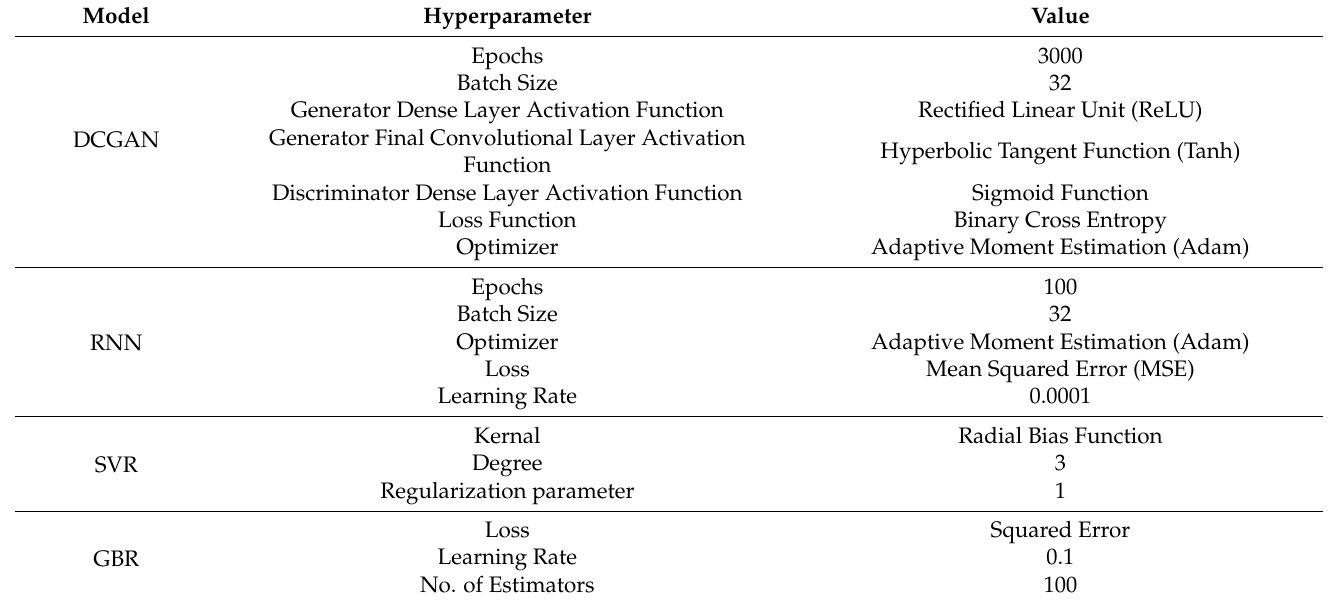
Table 5. Hyperparameter settings of DCGAN and ML